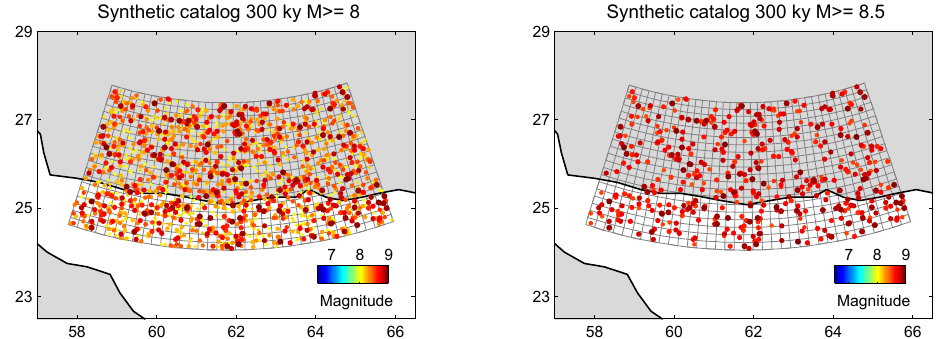
Figure B1. Same plot as in Fig. 2, but for the whole 300 kyr of the reference synthetic catalog for magnitudes above 8 and 8.5.